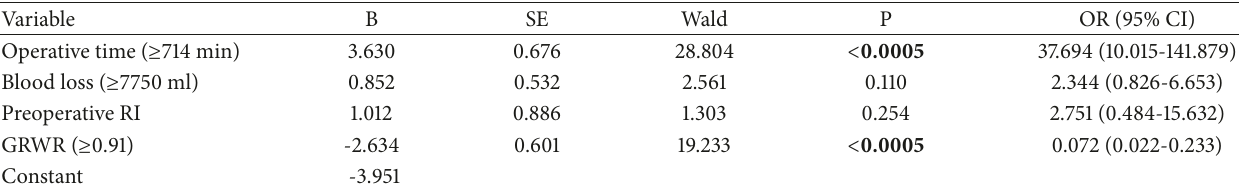
Table 5: Multivariate regression analysis for predicting the likelihood of chronic kidney disease at one